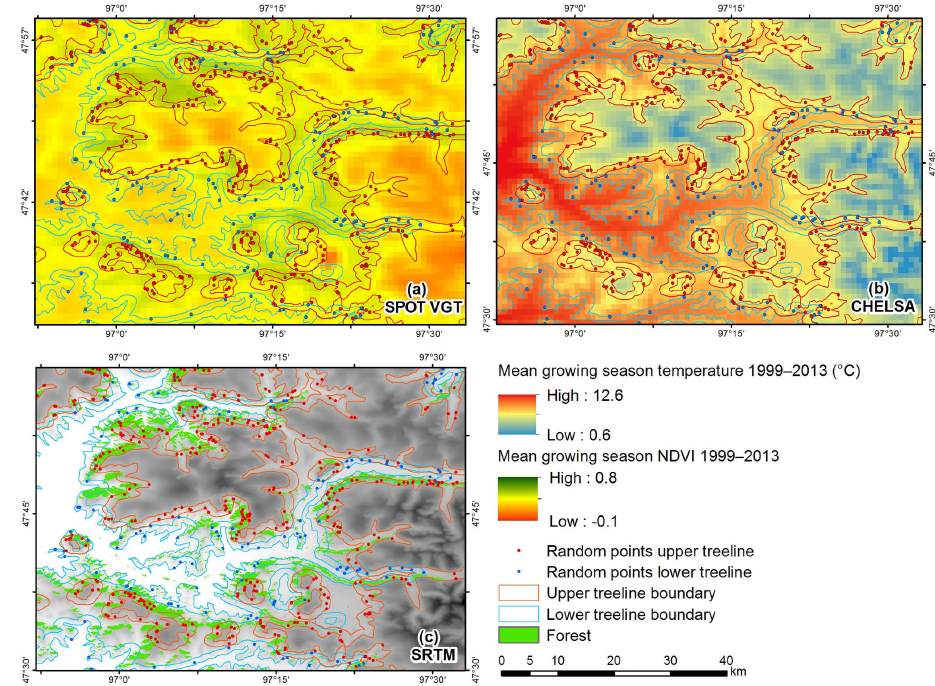
Figure 3. Examples for the spatial resolution of the different data: (a) mean growing season NDVI 1999–2013, (b) mean growing season temperature 1999–2013, (c) upper and lower treeline boundary from Landsat and SRTM